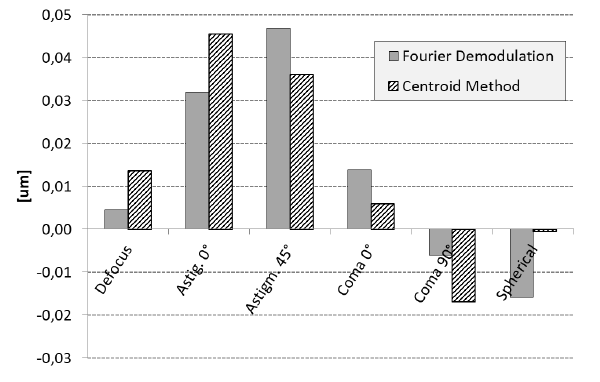
Figure 7. Calculated Zernike coefficients using Fourier demodulation (gray bars) and centroid method (bars with black lines) for the direct beam. Major distortions were found for vertical and horizontal